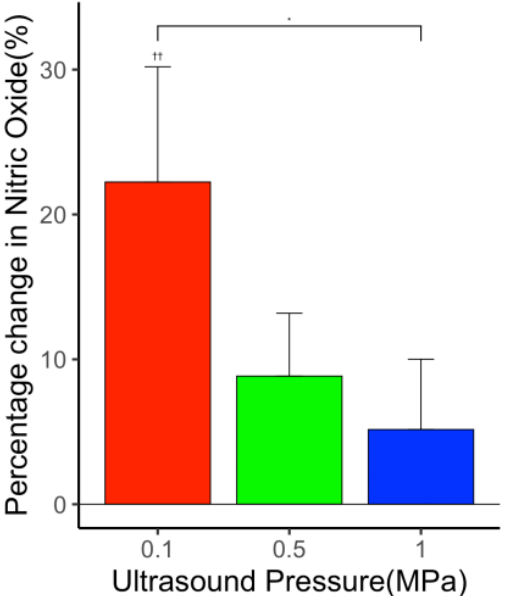
Figure 7. Effect of PUT on NO levels for various levels of ultrasound peak negative pressures—0.1, 0.5, and 1 MPa—applied with laser = 10 mJ/cm 2 showing increase in NO levels compared to control. n = 9 for each group. “*” indicates statistical significance between groups with p < 0.05. “††” indicates statistical significance between control and treatment group p < 0.01.